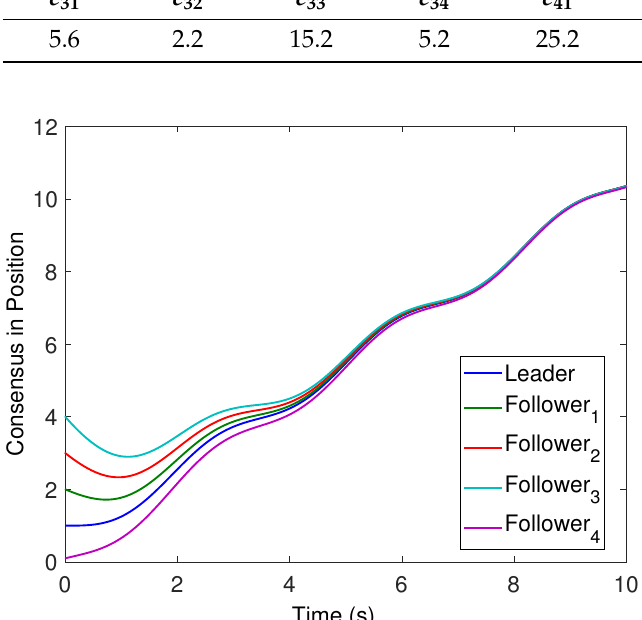
Figure 2. Position consensus of the four followers with leader position